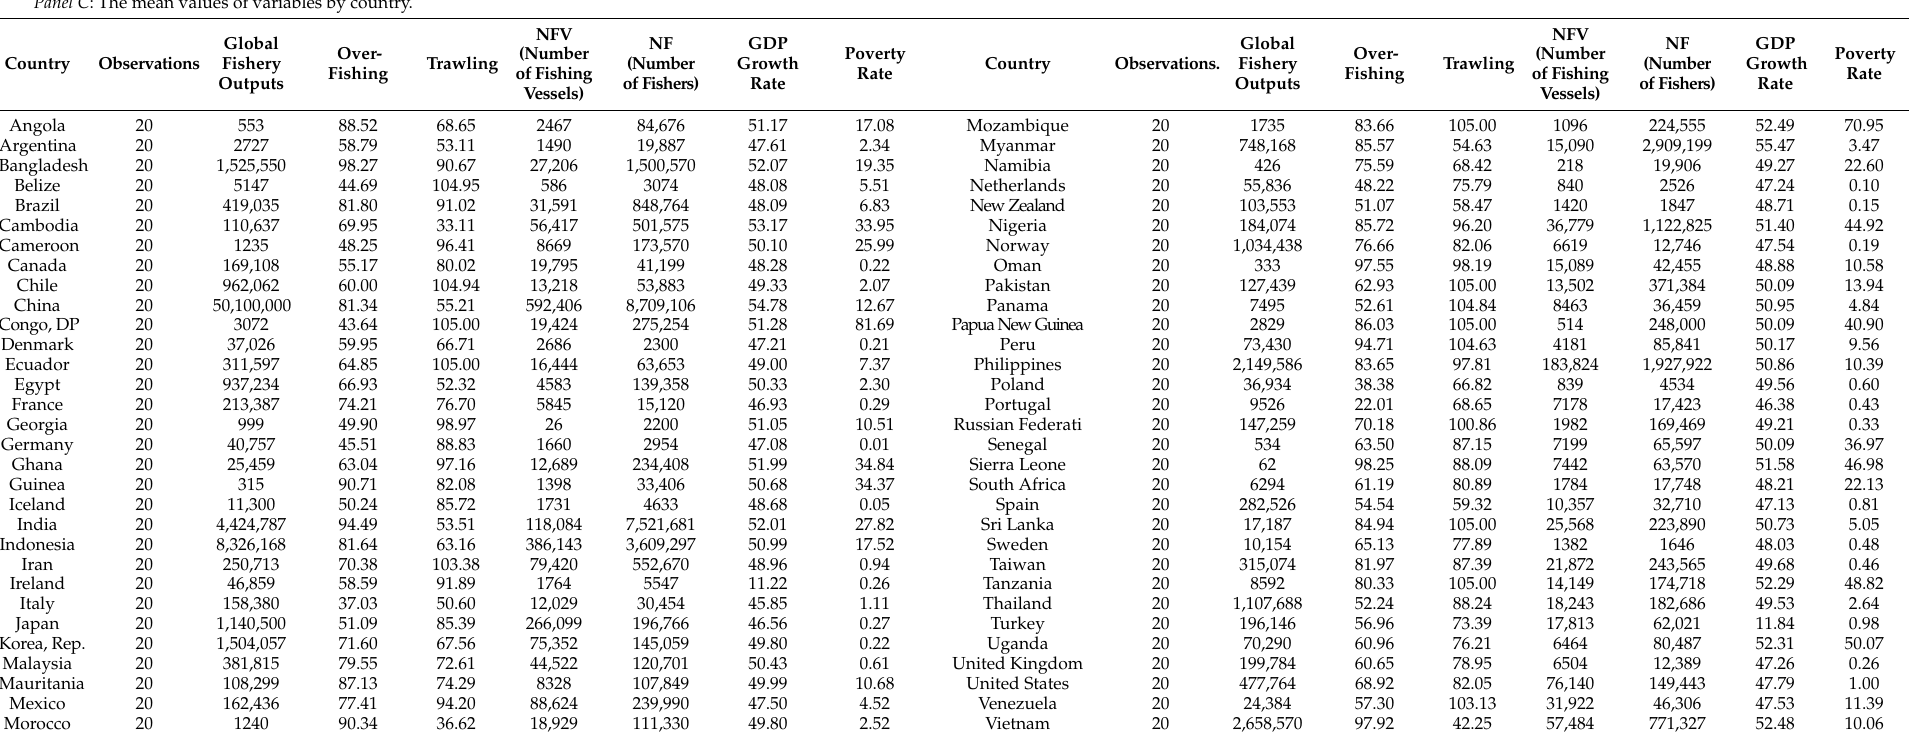
Panel C : The mean values of variables by